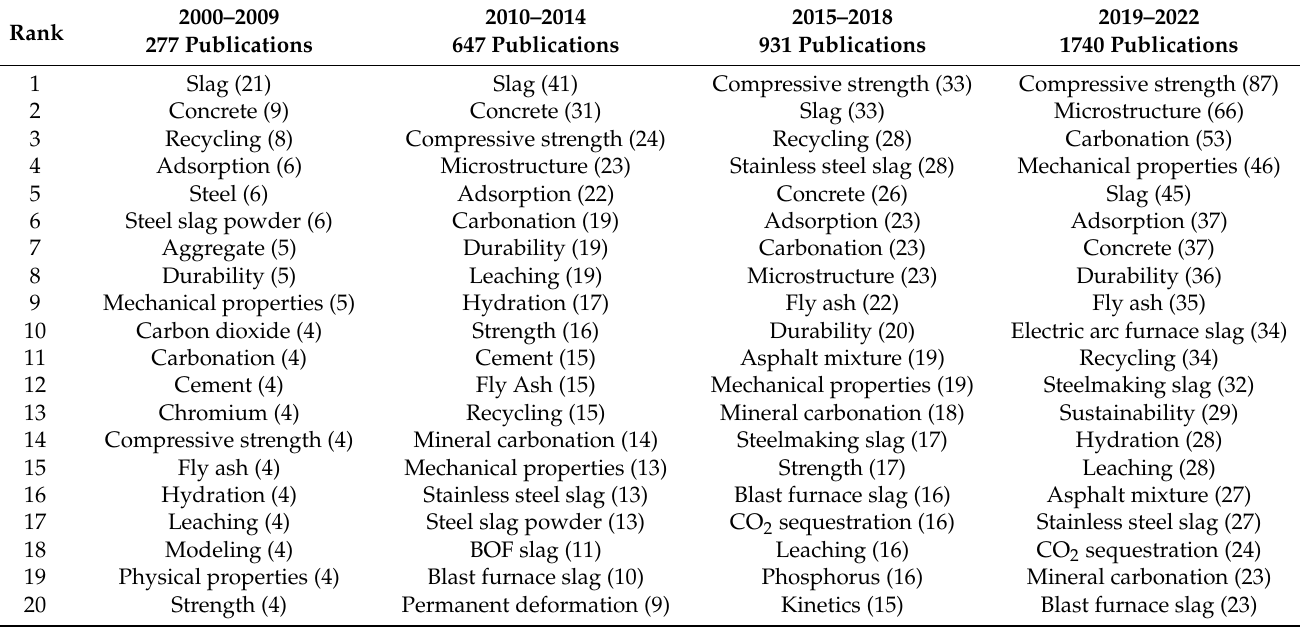
Table 3. The top 20 keywords in